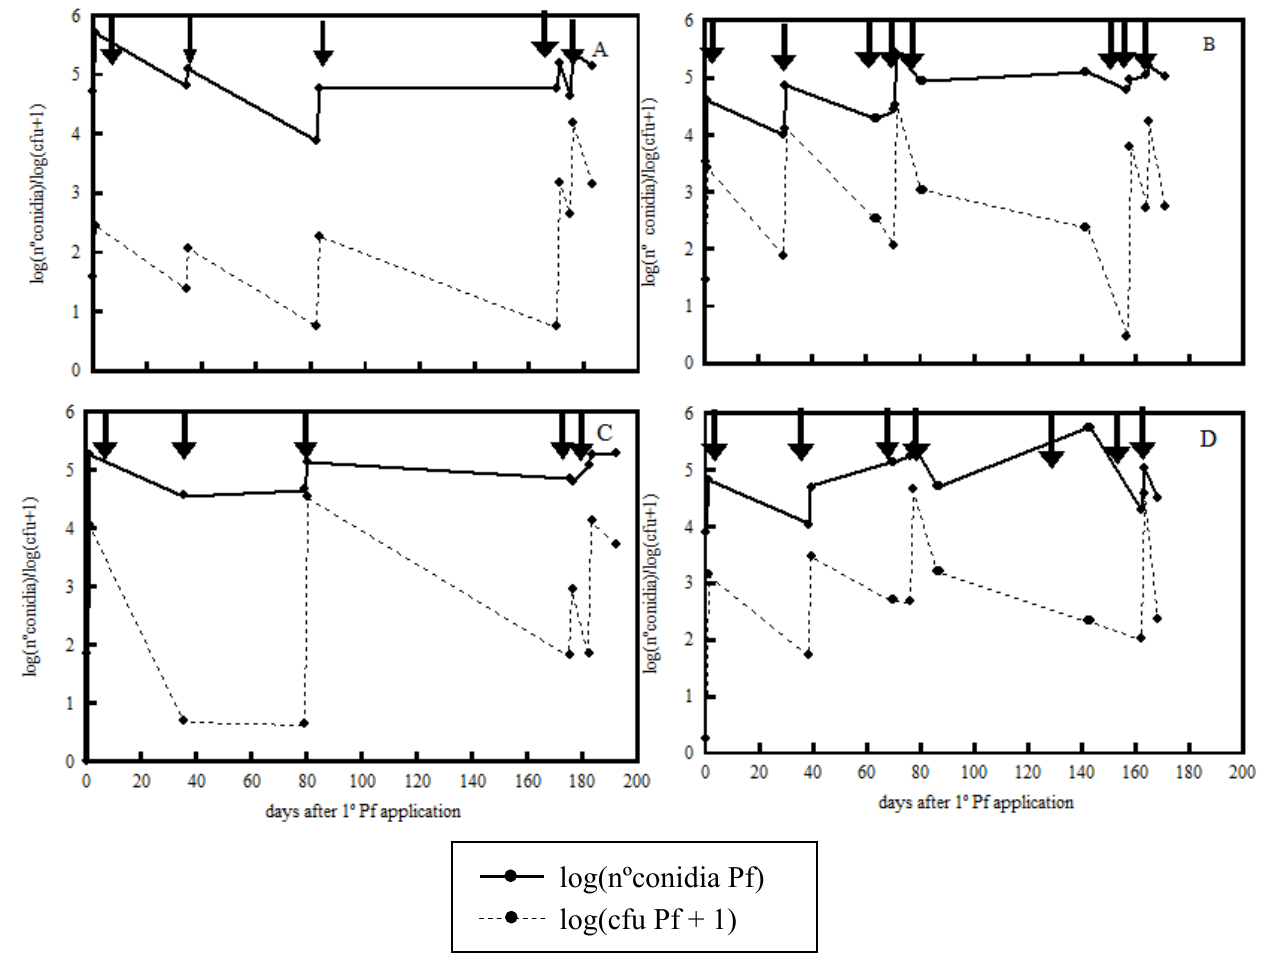
Figure 2. Population dynamics of Penicillium frequentans (Pf) after five or eight applications the FOR8 P. frequentans conidial formulation. The data are displayed as the logarithm of the number of conidia and the number of colony-forming units (CFU + 1) that were recovered from flowers or fruit in 2004 ( A ) and 2005 ( B ) in a commercial orchard in Alfarrás, Spain, and in 2004 ( C ) and 2005 ( D ) from a commercial orchard in Sudanell, Spain. The numbers of P. frequentans conidia were counted in a hemocytometer under a light microscope (×100). The number of CFUs of P. frequentans per square centimeter of surface of the Petri dish containing potato dextrose agar that was supplemented with 0.5 g L − 1 streptomycin was counted with the naked eye. Data are the mean of four replicates, with 10 flowers or five fruits per replicate. The vertical arrows show the times of the Pf